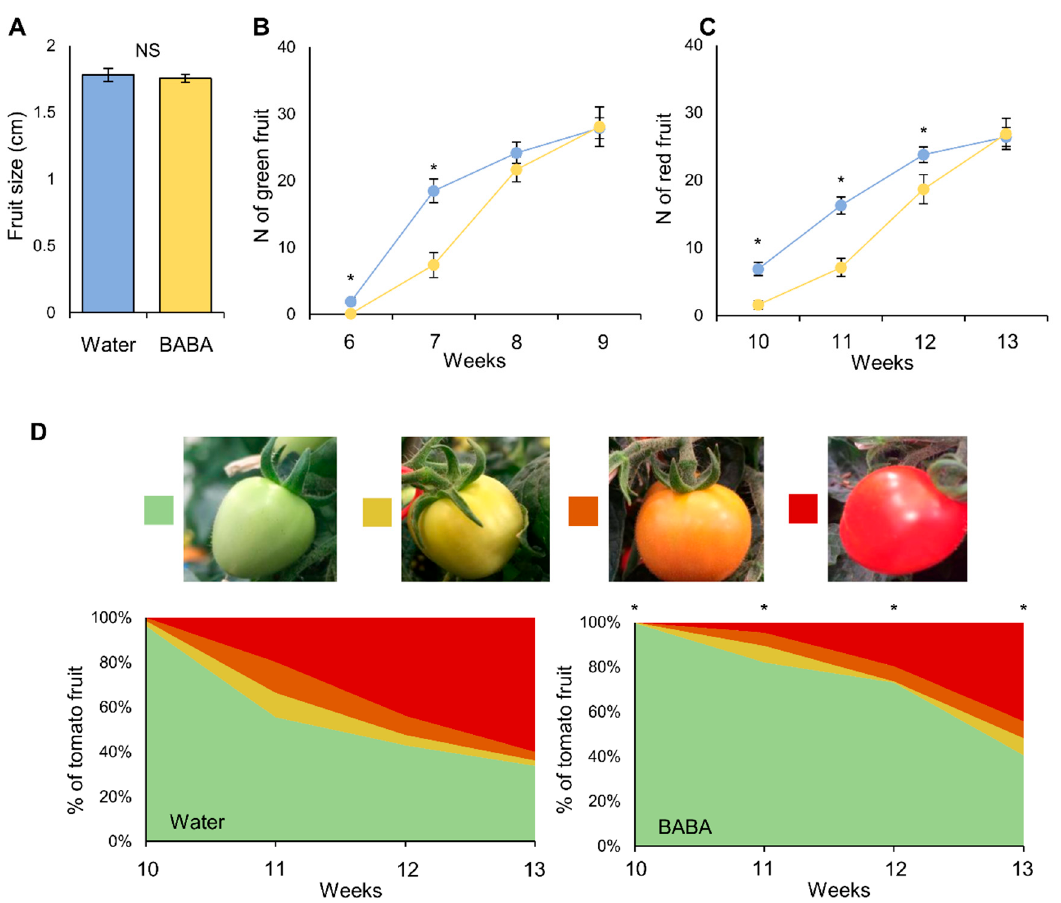
Figure 2. Effect of BABA on fruit yield and development. ( A ) fruit size (cm) from plants treated with water (blue) or 500 µM BABA (yellow). NS: not statistically significant ( t -test, P > 0.05). ( B ) number of green fruit produced from water (blue)- or BABA (yellow)-treated plants after weeks of growth. Asterisks indicate statistically significant differences ( t -test, P > 0.05). ( C ) number of ripped fruit produced from water (blue)- or BABA (yellow)-treated plants after weeks of growth. Asterisks indicate statistically significant differences ( t -test, P < 0.05). ( D ) Proportion of fruit at different stages of fruit ripening in control and BABA-treated plants, expressed as percentage of occurrence per treatment at different weeks of growth. Asterisks indicate statistically significant differences between distributions at specific timepoints (Chi-square test, P < 0.05).